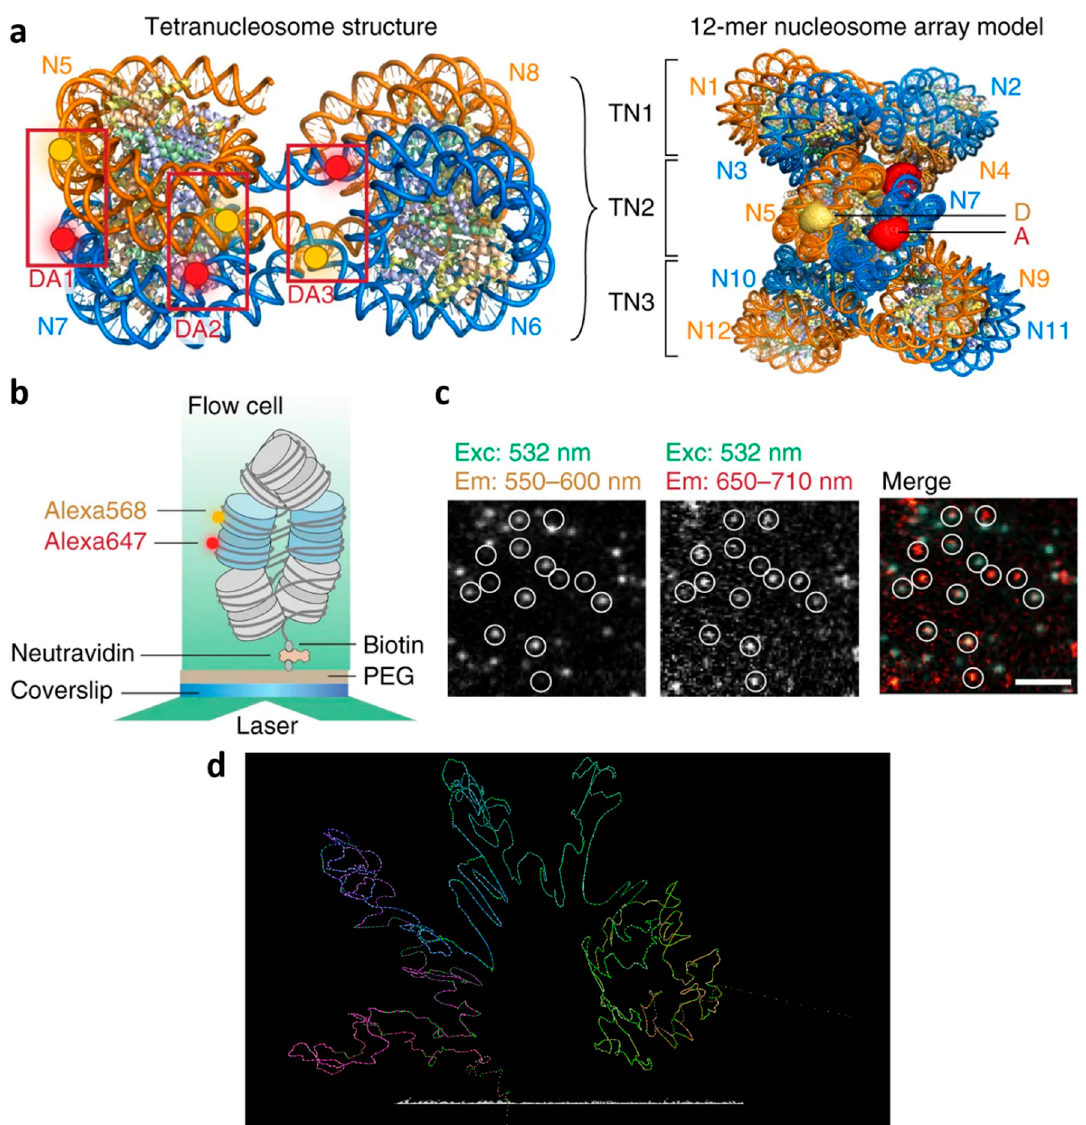
Figure 2. Imaging chromatin conformation. (a–c) Pairs of fluorescent dyes are used to study interactions such as binding between labeled proteins. Single molecule Förster resonance energy transfer (FRET) facilitates the real-time detection of chromatin conformational dynamics. ( a ) Left: A tetranucleosome structure is labeled with three dye pairs DA1, DA2, and DA3. Right: The chromatin fiber can be modeled as a stack of tetranucleosome (TN) units. The middle tetranucleosome carries the fluorescent labels, whose accessible volume is displayed. D donor, A acceptor labels, N nucleosomes. ( b ) Scheme of the total internal reflection fluorescence (TIRF) experiment to measure intra-array single molecule FRET. ( c ) Microscopic images showing FRET data of single chromatin arrays, scale bar: 5 µm. ( d ) Structural data from super-resolution microscopy can be combined with sequencing information (bottom) [91] to yield with higher confidence a model of the underlying structure. (a–c) © 2018 under the Creative Commons license [92] by Kilic et al. [83]. (d) Created with CSynth [91].